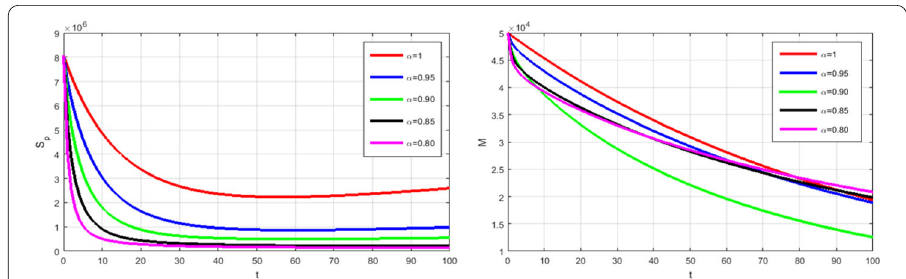
Figure 4 Numerical simulations of S p , M at different α , (cid:21) = 1